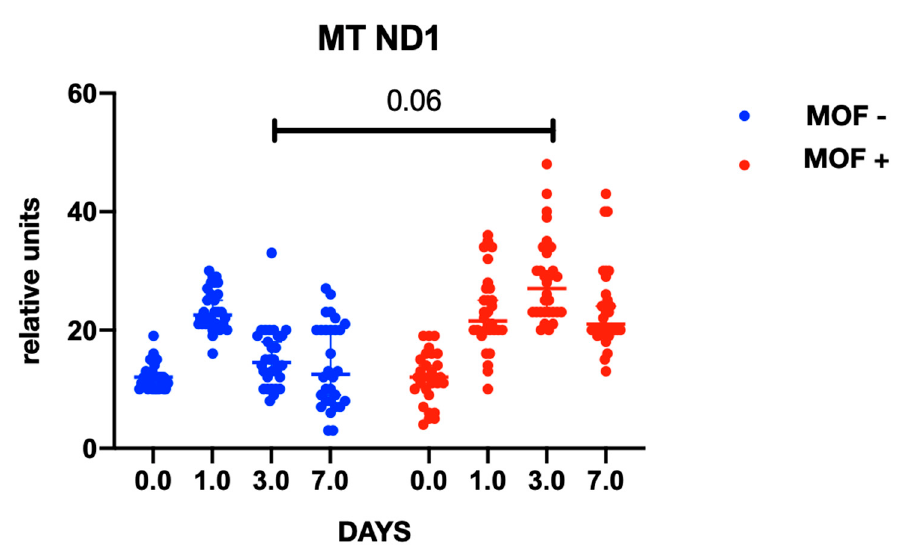
Figure 4. NADH1 gene expression.